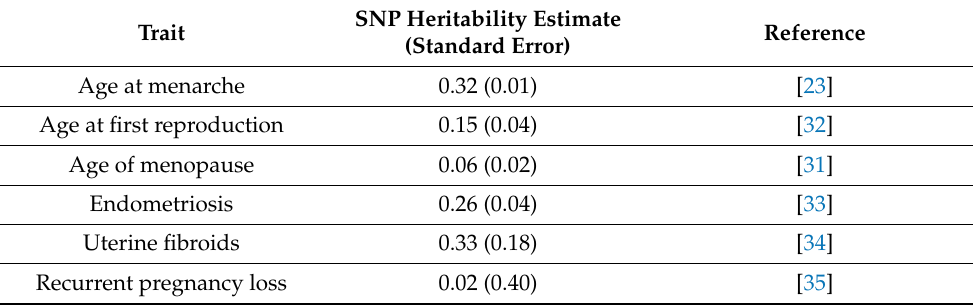
Table 2. Estimates of the SNP Heritability for reproductive traits from Table 1 where these are available. SNP Heritability Estimate Trait (Standard